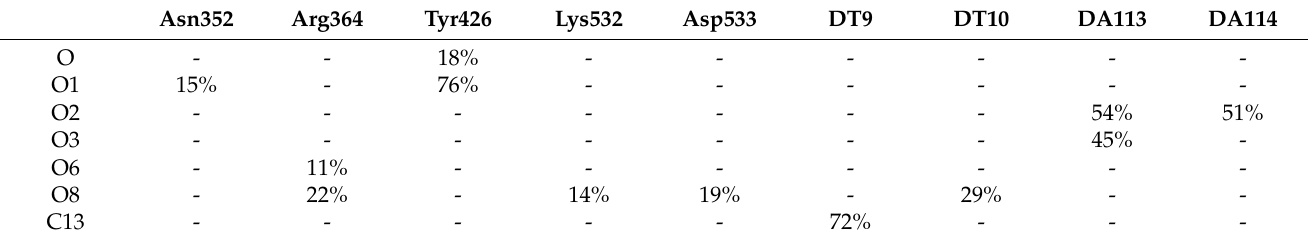
Table 3. Percentage of the permanence of most relevant non-covalent interactions between the at- oms of the compound c6 and the amino acids or nucleotides of the receptor 1T8I.